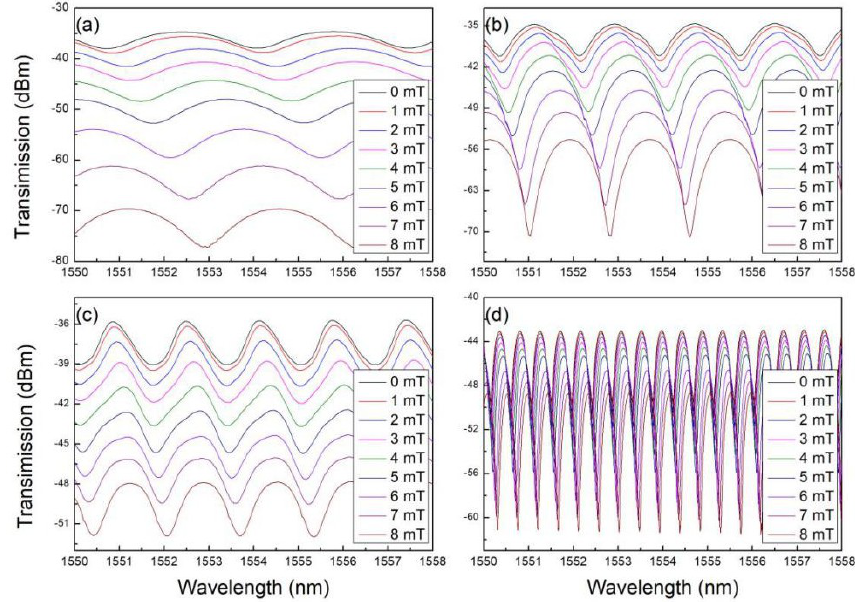
Figure 3. Transmission spectra of the MKRs at various magnetic fields. The ring diameters of the MKRs are 155 µ m ( a ), 289 µ m ( b ), 328 µ m ( c ), and 594 µ m ( d